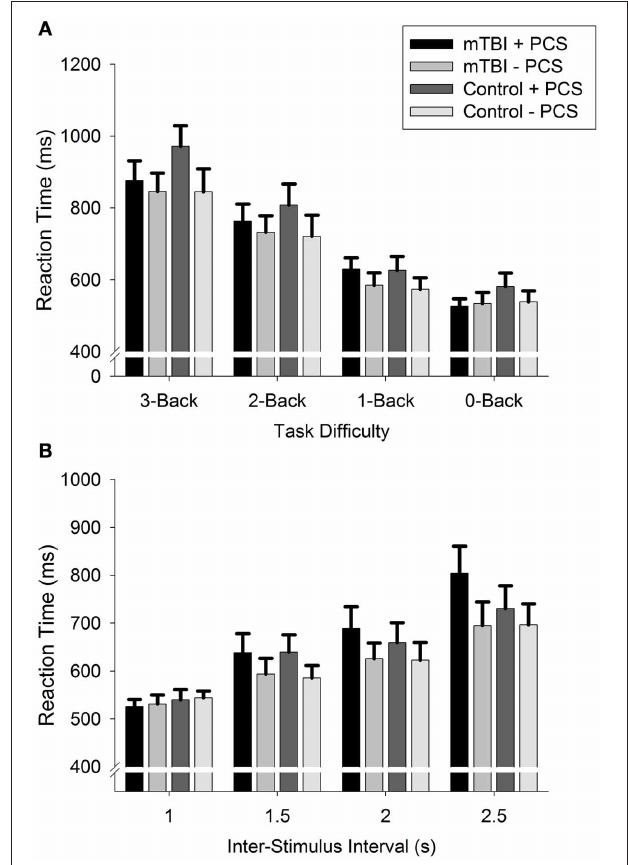
FIGURE 1 | Error rate for (A): n-Back and (B): PVSAT tasks. ∗ p < 0 . 05, ∗∗ p < 0 . 01.